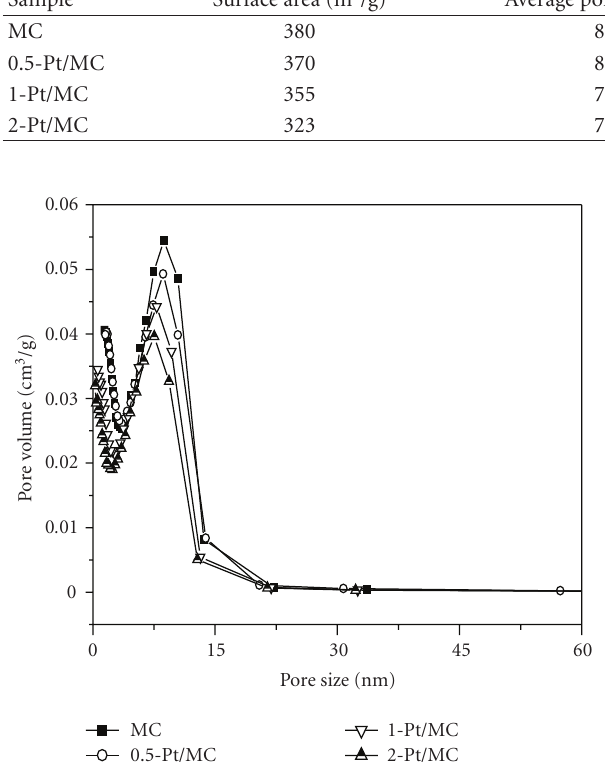
Figure 2: The pore size distribution curve of the as-prepared MC, 0.5-Pt/MC, 1-Pt/MC, and 2-Pt/MC samples.